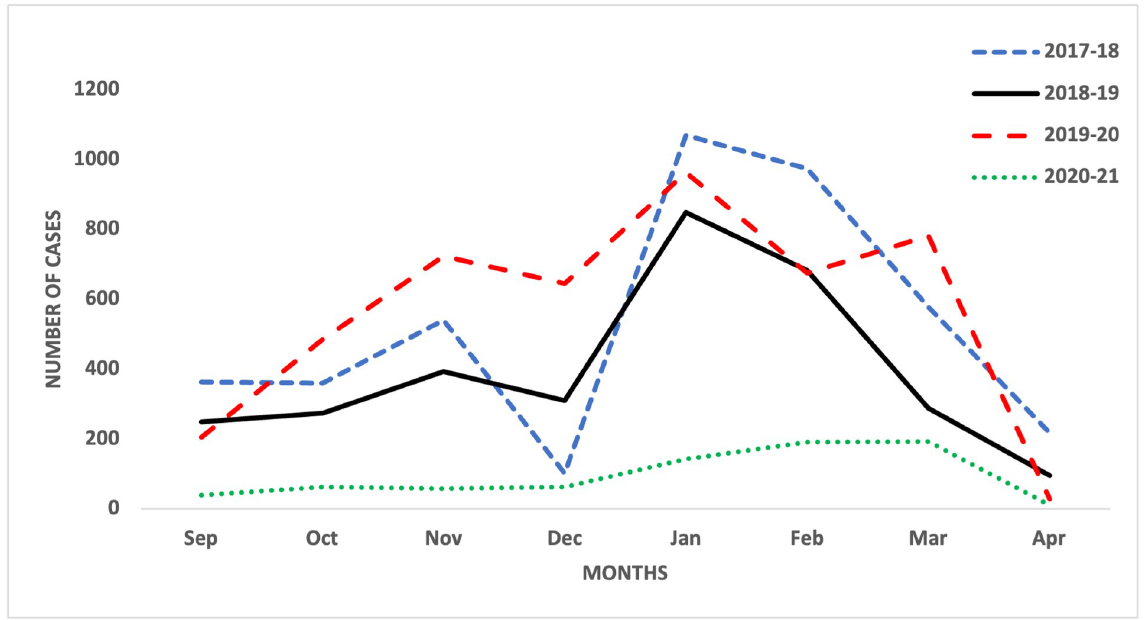
Fig 2. Monthly count of ILI in the UK AF before and during the COVID-19 pandemic.